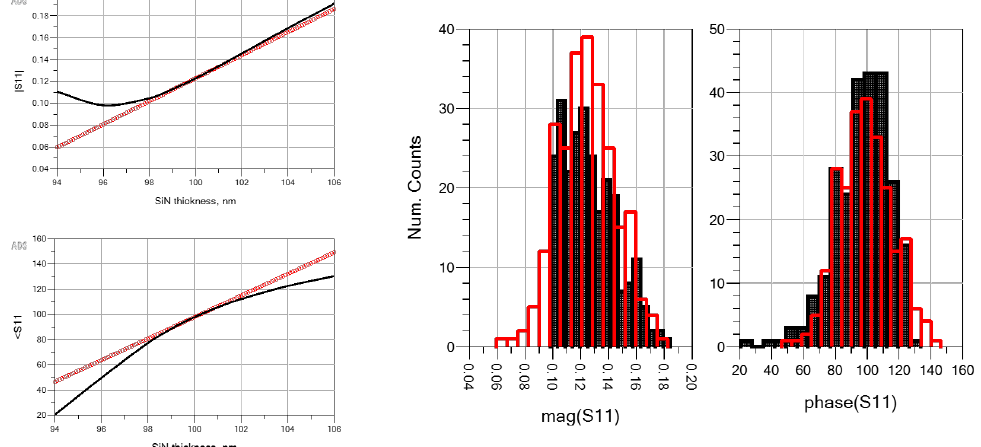
Figure 9. ( Left ): deterministic analysis of the OMN PIV with varying t SiN : incremental approach (black lines) and linearized approach (red symbols). ( Right ): Monte Carlo analysis of the OMN with PIV: the incremental (black histograms) and linearized (red histograms) approaches are